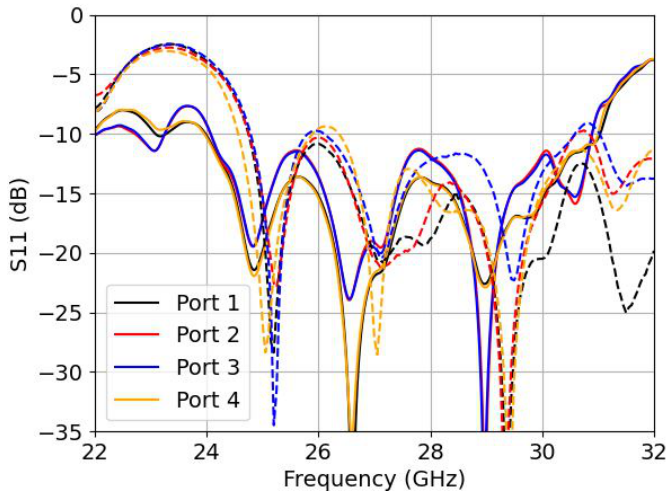
Figure 9. Input reflection coefficient (for measured - - and simulated -) for each port independently.